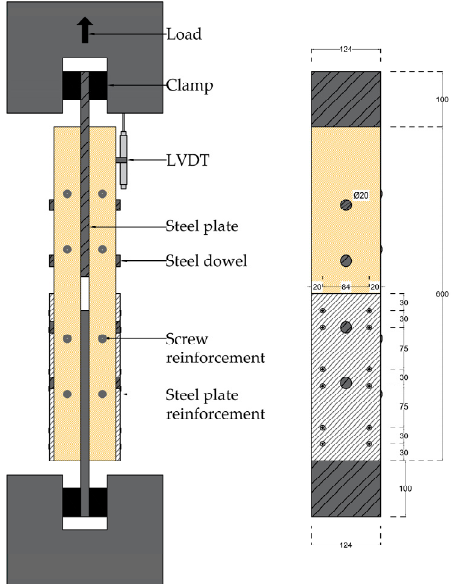
Figure 4. Specimen set-up ( left ) and dimensions for the specimen ( right ).